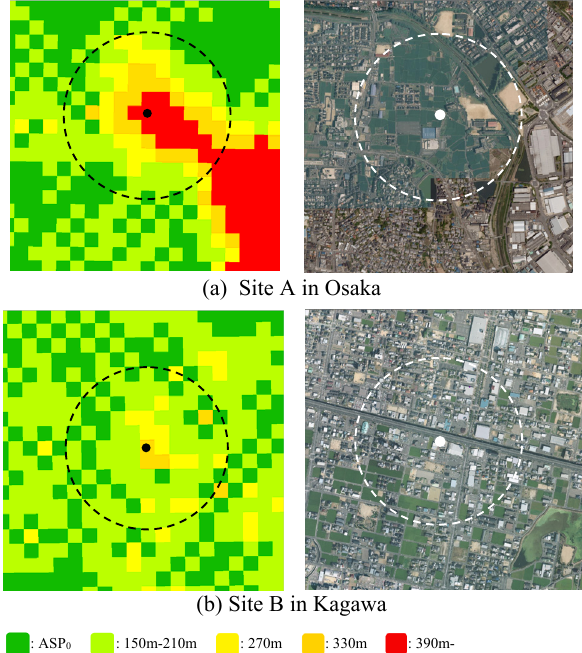
Figure 7 . Comparison between the large ASPs and aerial photographs in enlarged views of study areas. Dotted lines show the circles with radius ASP (= 330 m) which is indicated with colour of centre pixels in ASP